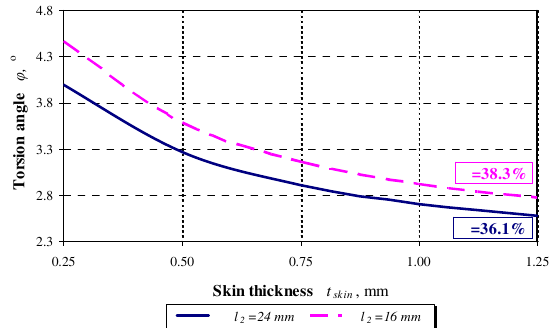
Fig 12. Influence of skin thickness on torsion angle